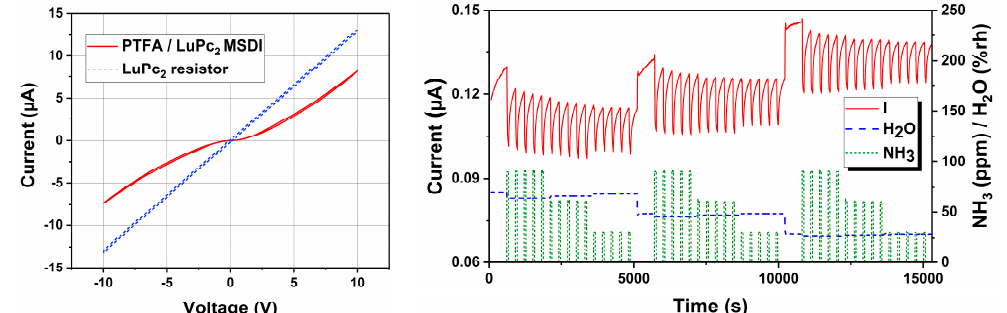
Figure 4. Current-voltage characteristics of a LuPc2 resistor (dotted line) and a PTFA/LuPc2 lateral heterojunction ( left ); response to NH3 (90, 60 and 30 ppm) in synthetic air, at different relative humidity levels, of a PTFA/LuPc2 lateral heterojunction ( right